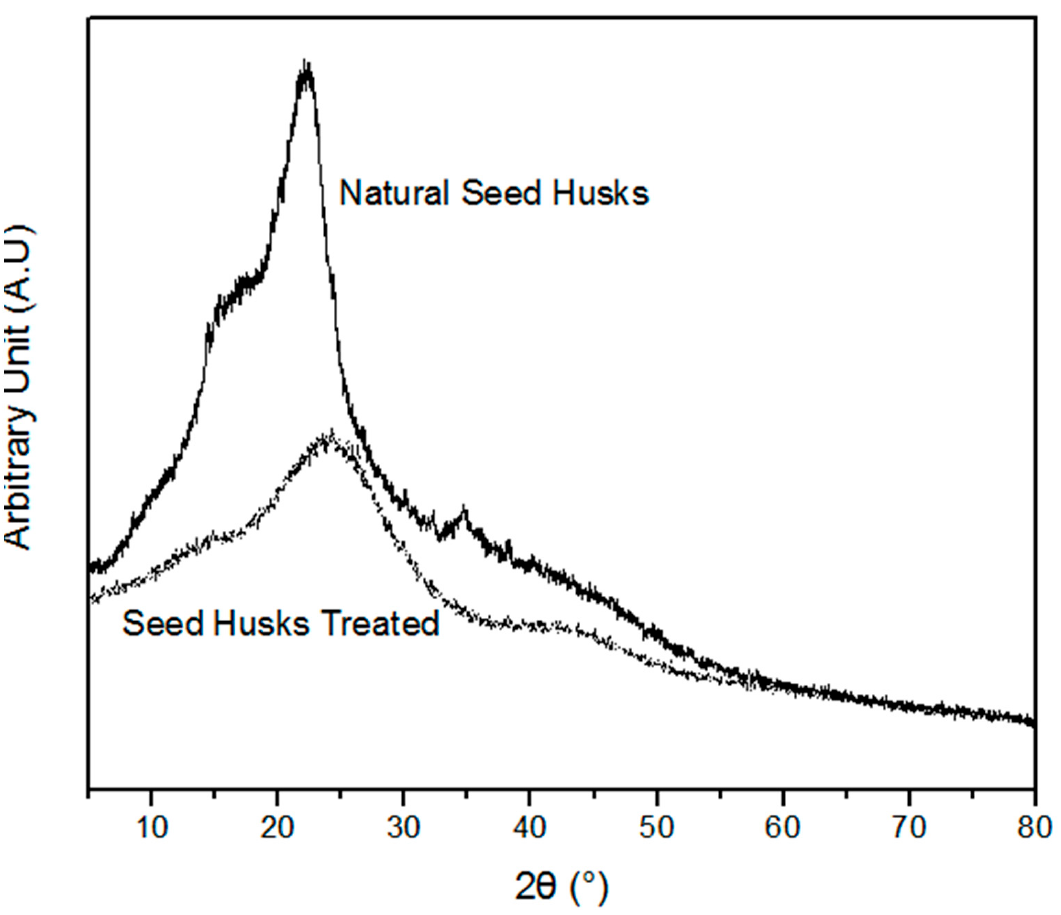
Figure 4. XRD diffractogram of the Moringa oleifera Lam. seeds and of the adsorbent synthesized.